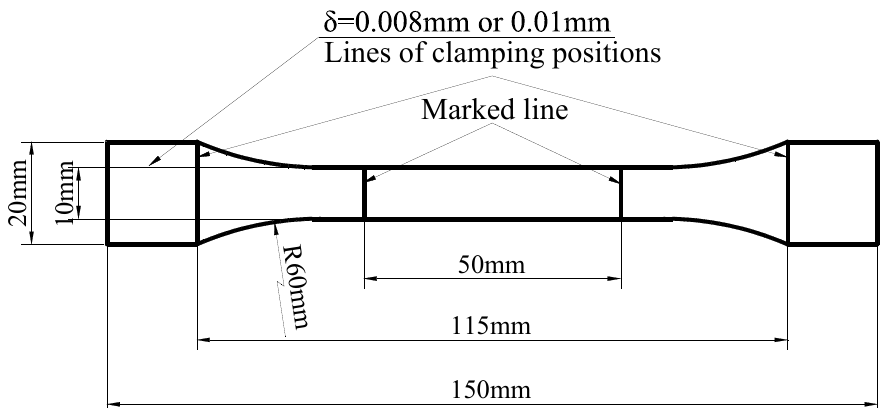
Figure 3. Standard tensile sample of film.